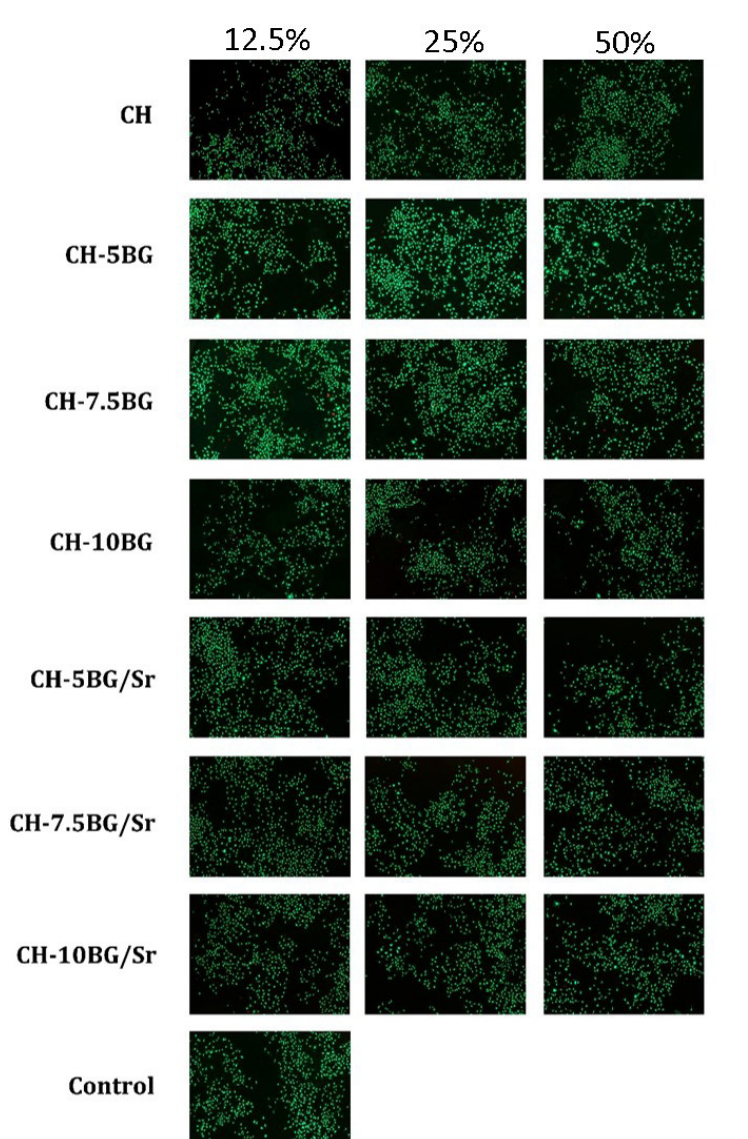
Figure 7. Cell viability in culture of pre-osteoblastic cells exposed to extracts of compositions based on calcium aluminate cement (CH) containing different contents of bioactive glass (BG) and strontium (Sr) in concentrations of 12.5%, 25% and 50% or in their absence (control) for 3 days. Green marking indicates viable cells and red, dead cells. Scale bar = 200